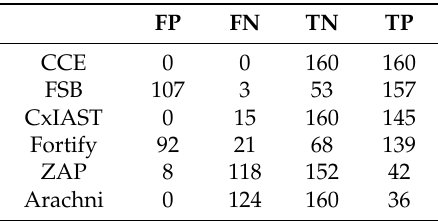
Table 2. Metrics applied to individual tools.